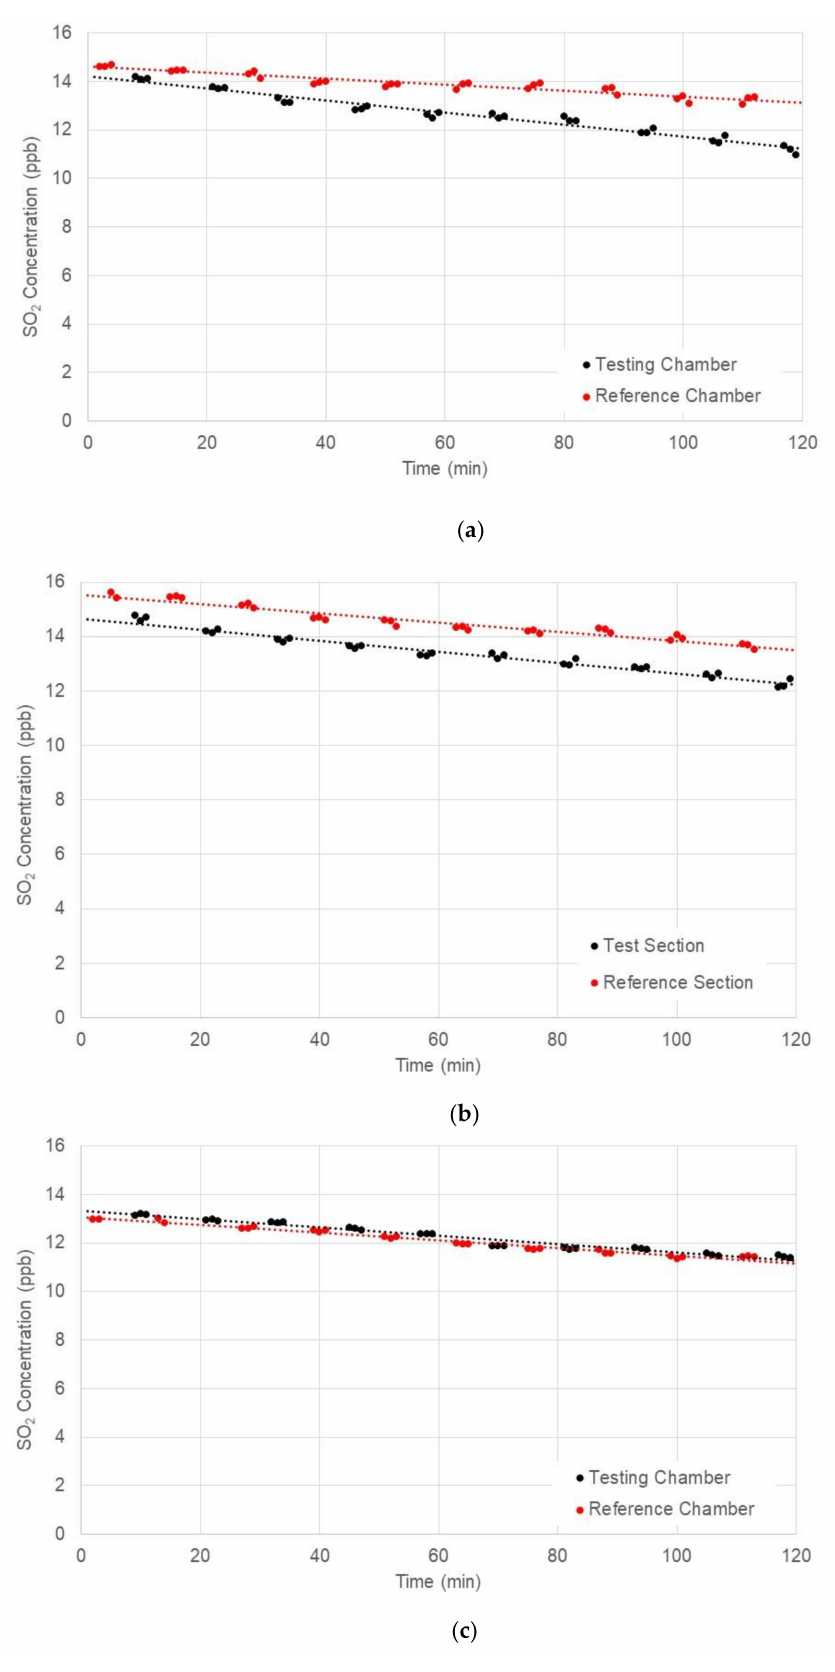
Figure 13. Comparison of SO 2 concentrations measured in testing and reference chambers at different levels of solar radiation: ( a ) Average Solar Radiation = 564 W/m 2 ; ( b ) Average Solar Radiation = 358 W/m 2 ; and ( c ) Average Solar Radiation = 67 W/m 2